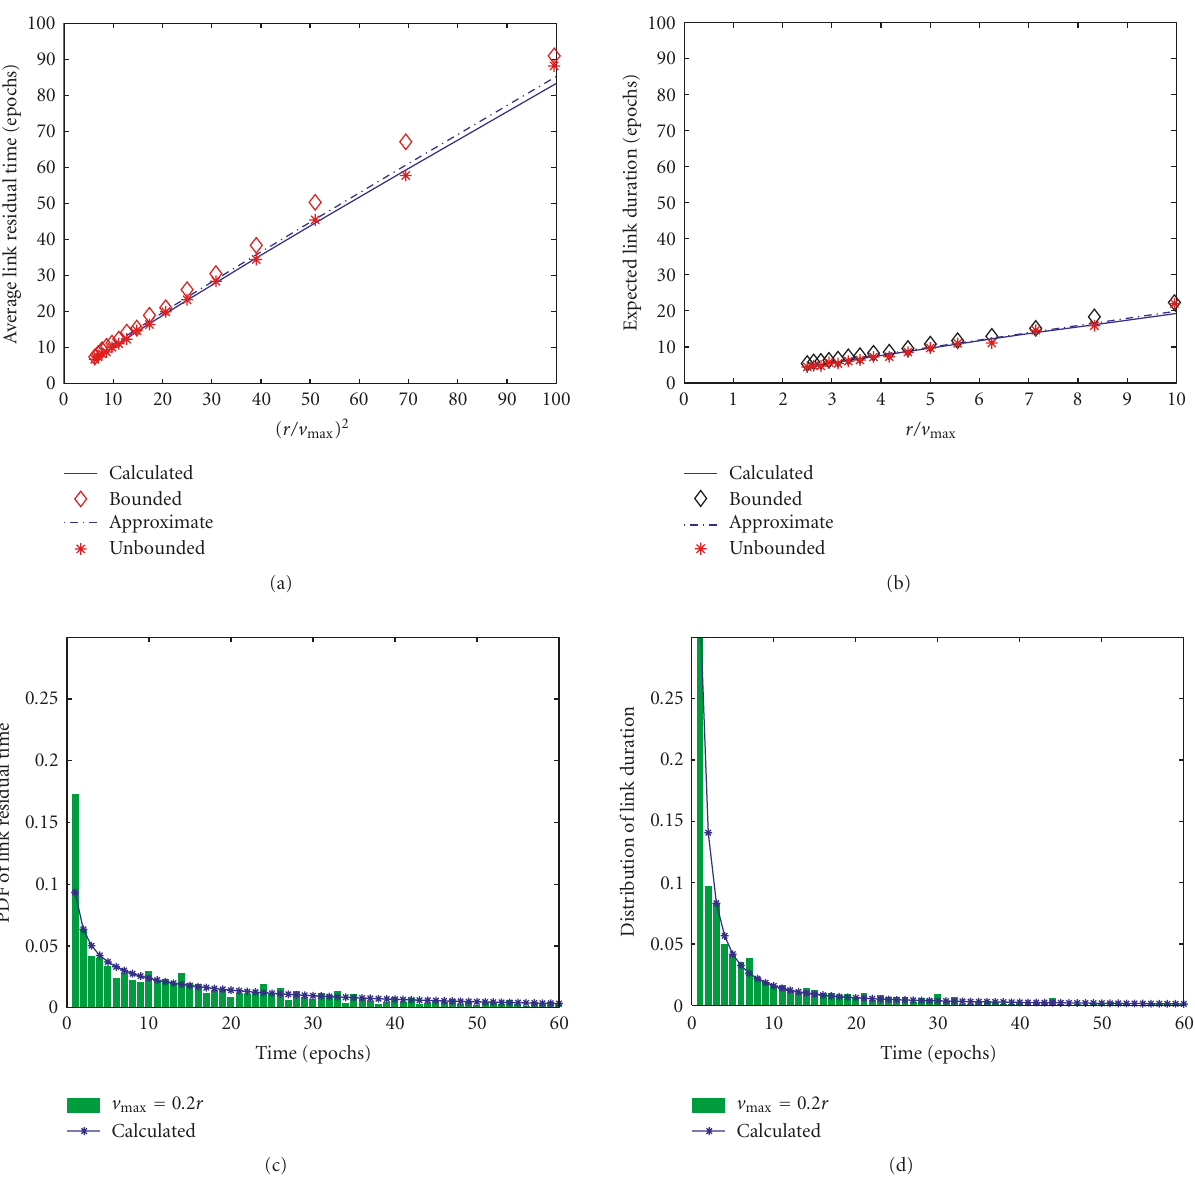
Figure 7: Comparison of metric calculations and simulated results for link residual time and link duration. Each MN moves at a randomly chosen velocity during each epoch, which has uniformly distributed speed in the range [0, v max ] and uniformly distributed direction in the range [0,2 π ) (a) Comparison of calculated, approximate, and experimental average link residual time values for both bounded and un- bounded simulation areas. Calculated values are from (30). The approximation is from (54). (b) Comparison of calculated, approximate, and experimental average link duration values for both bounded and unbounded simulation areas. Calculated values are from (33). The approx- imation is from (56). (c) Comparison of calculated and experimental distributions of the link residual time for an unbounded simulation area. Calculated values are from (26). (d) Comparison of calculated and experimental distributions of the link duration for an unbounded simulation area. Calculated values are from